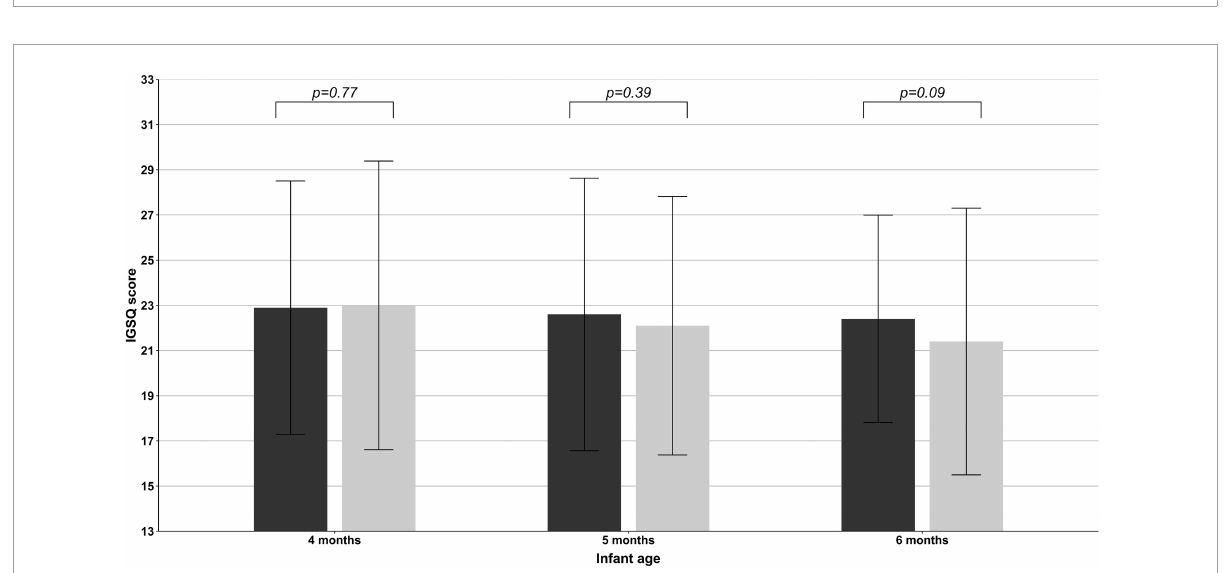
FIGURE3 Mean ± SD Infant Gastrointestinal Symptom Questionnaire (IGSQ) scores at infant age 4, 5, and 6 months in formula-fed (black bars) and breastfed infants (gray bars) in the FAS